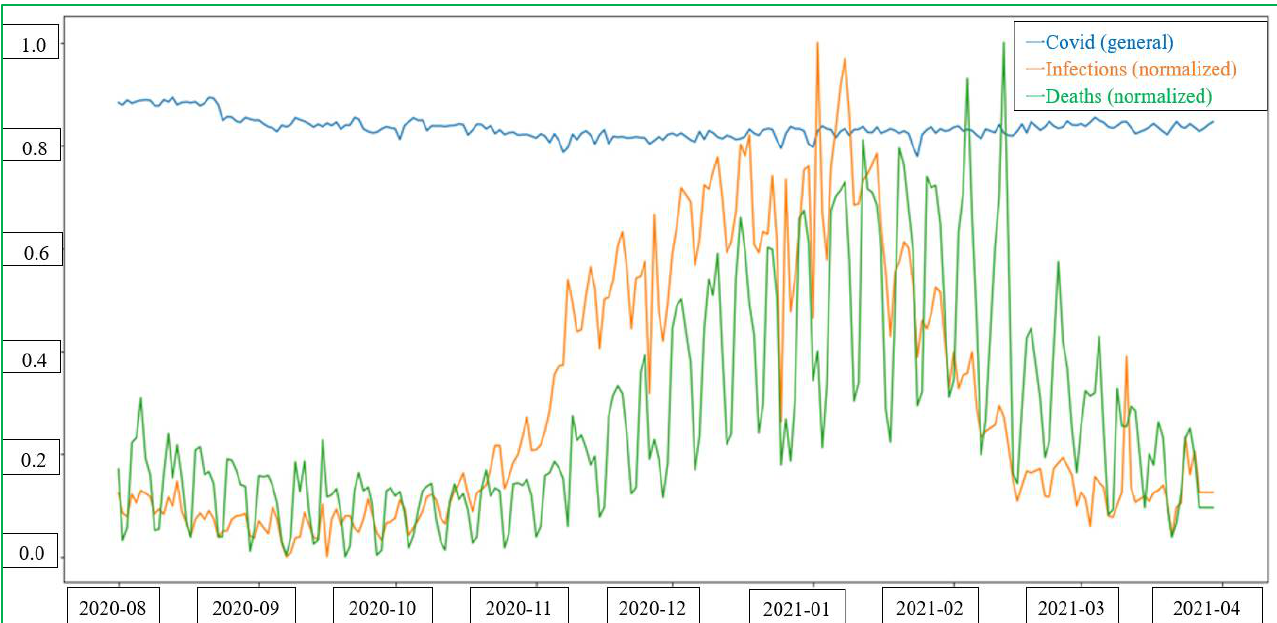
Figure 3. Comparison of the progress of the pandemic and the levels of citizen concerns. Blue: COVID-19 (General) Concern Level; Orange: Infections (normalized); Green: Deaths (normalized).